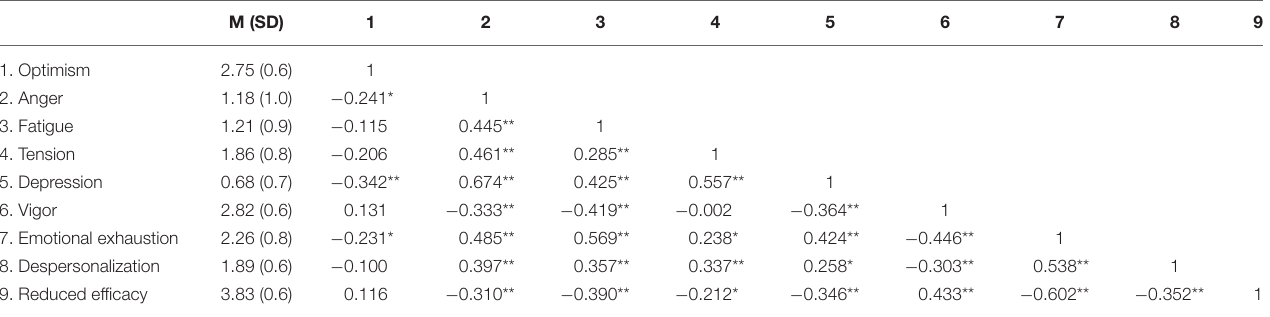
TABLE 2 | Descriptive and correlation